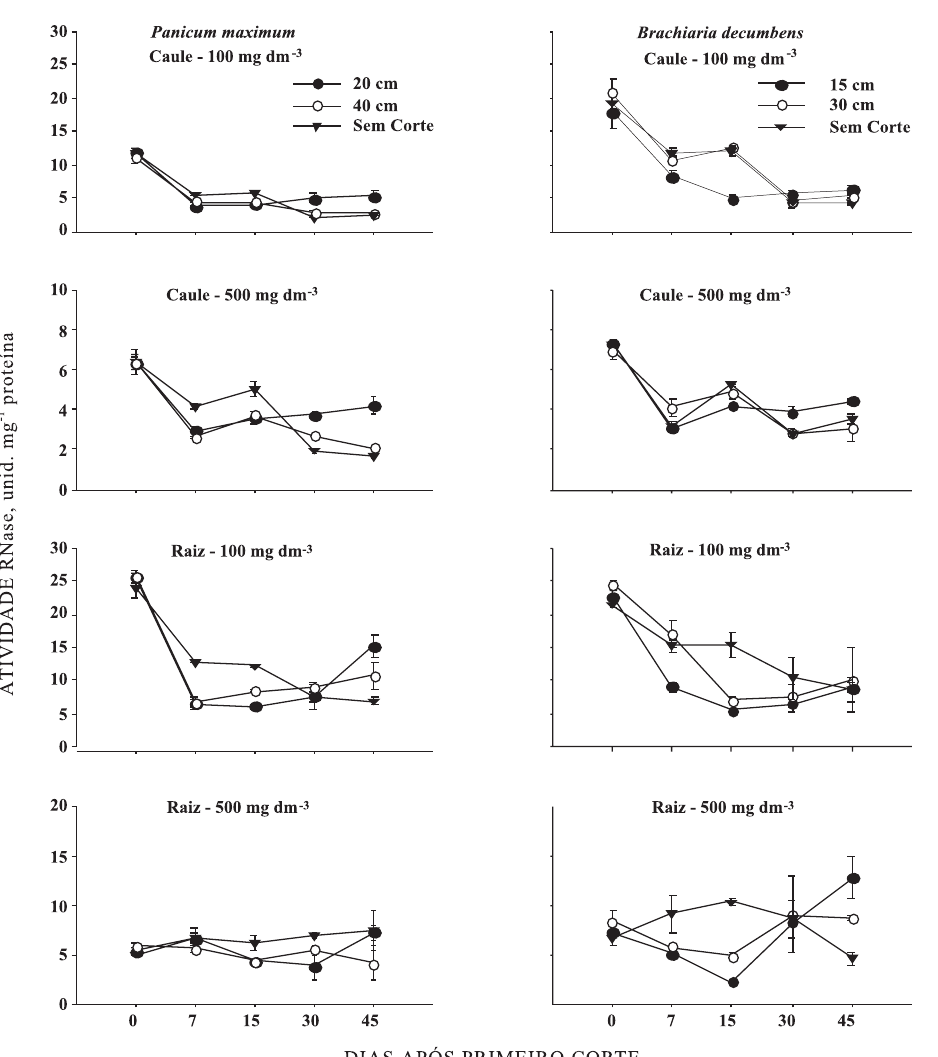
Figura 4. Atividade da ribonuclease (RNase) no caule e raiz das forrageiras Panicum maximum e Brachiaria decumben s fertilizadas com 100 e 500 mg dm -3 de P e mantidas sem corte e com duas alturas de corte, em amostras coletadas aos 60 dias após o transplantio das plântulas, quando se realizou o primeiro corte (tempo zero), e depois, aos sete, 15, 30 e 45 dias. As linhas verticais representam os